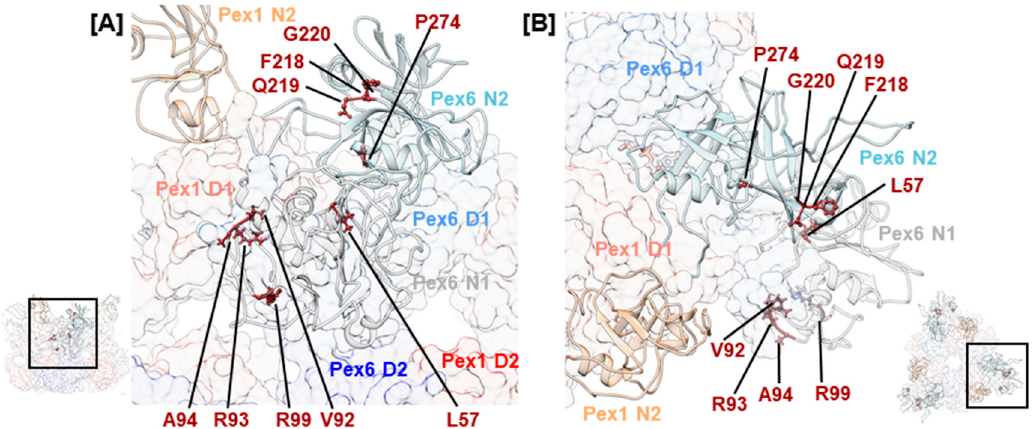
Figure 6. Structural mapping of mutations that concern the N-terminal domains N1 and N2 of Pex6. Concerned amino acids and ATP are shown as sticks. Insets show a side view of the hexamer with Pex6 in the front position ( A ) and a top view of the Pex1 / Pex6 complex ( B ). Enlarged areas are indicated.